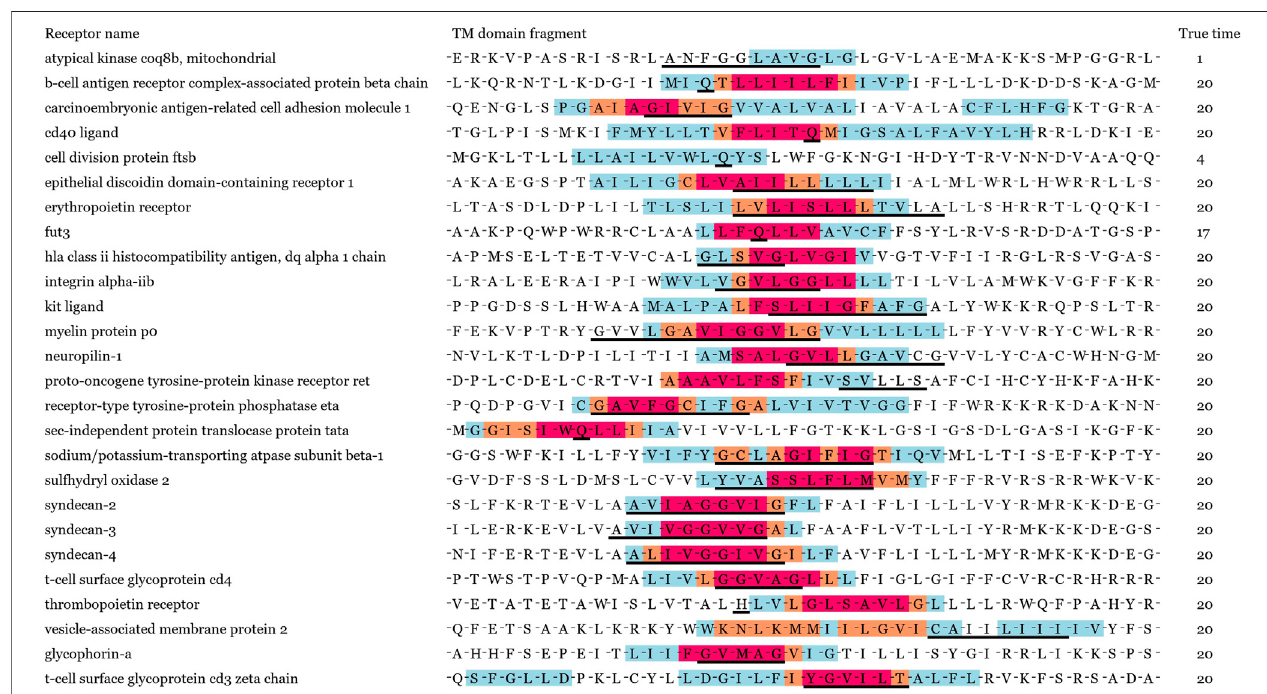
FIGURE 2 | Visualization result of 26 known dimers. True time represents the total true prediction number in twenty prediction results. Black solid line shows key residues for known dimerization process. Different levels of potential motifs have been labeled in red, orange, and blue, respectively. The red denotes to the most important residues in dimerization.